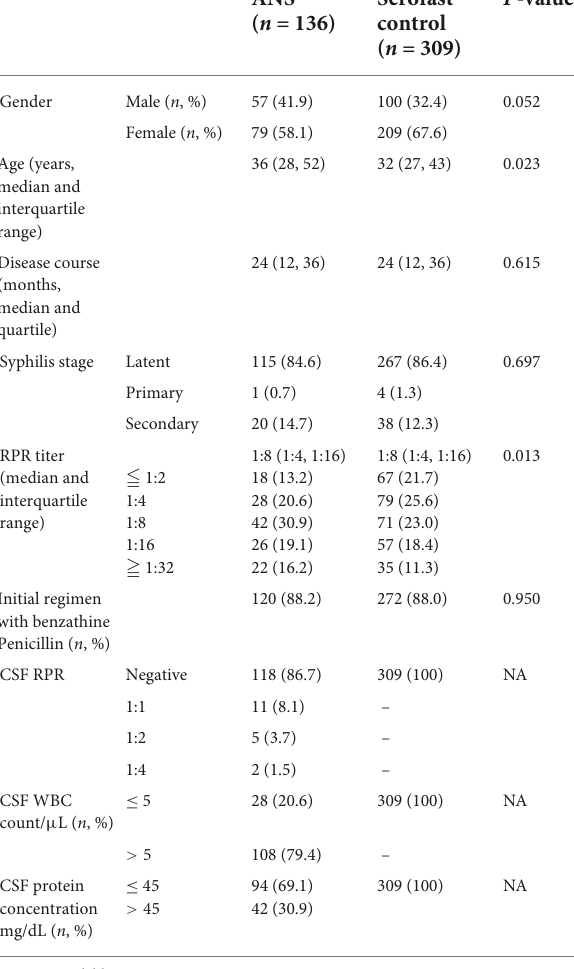
TABLE 1 Demographic and clinical characteristics of the ANS and the serofast control groups.